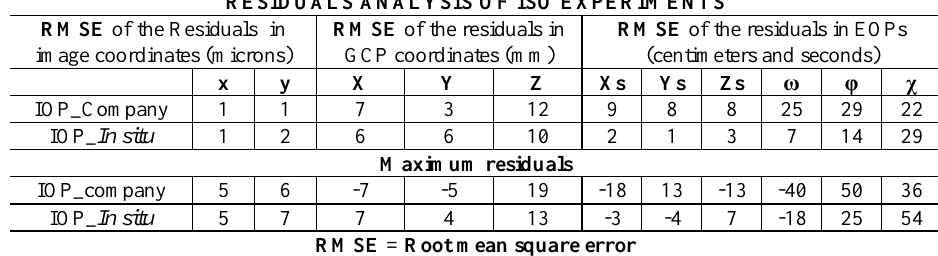
Table 5. Main results of the residuals analysis of the ISO experiment of the first block with control